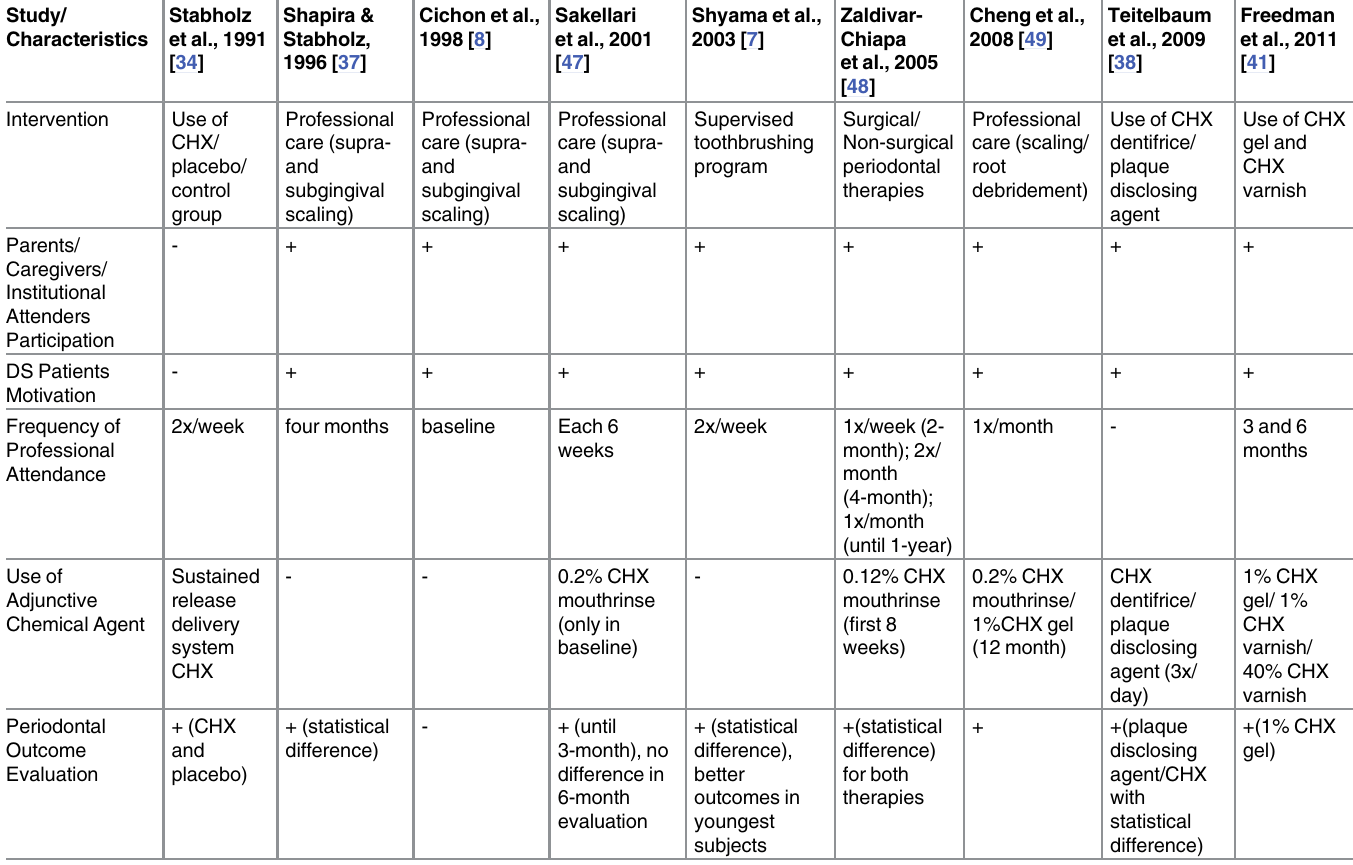
Table 3. Characteristics of preventive programs and periodontal